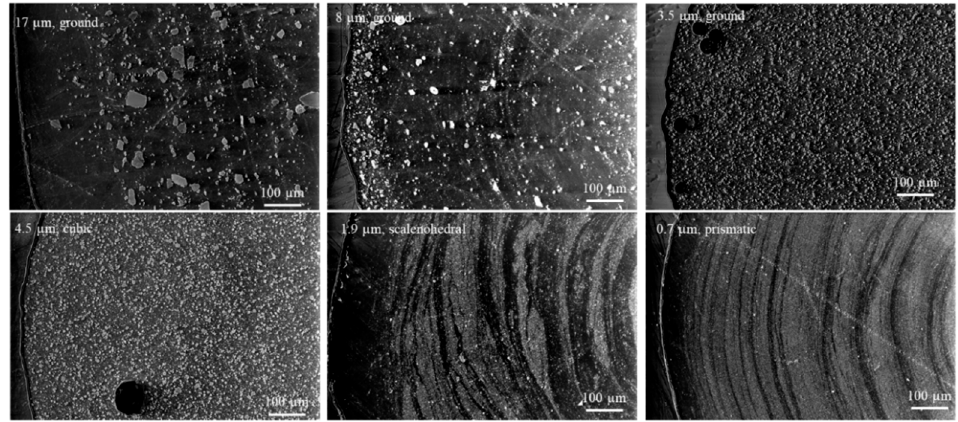
Figure 5. ESEM images of EVA/CaCO 3 extruded implant samples cross-sectioned perpendicular to flow.